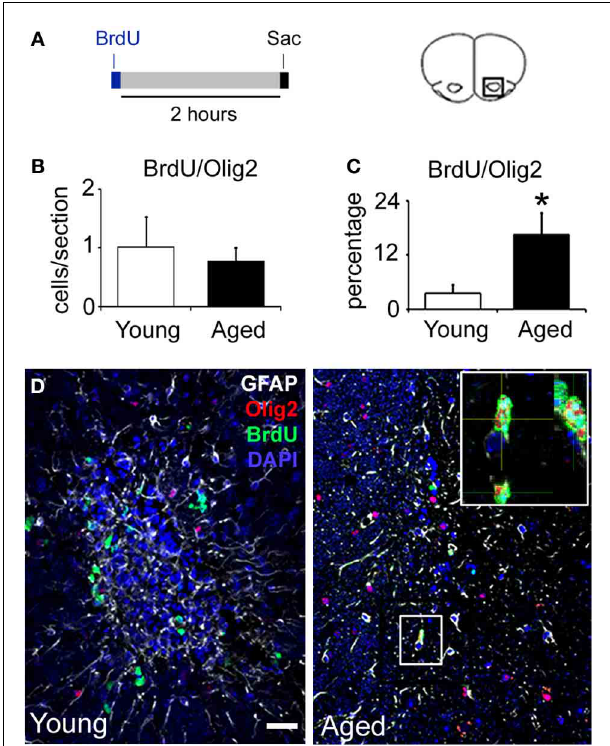
FIGURE 4 | A high percentage of the RMS proliferative cells pertain to the oligodendroglial lineage. (A) Animals received a single dose of BrdU and were euthanized 2h after. (B) Bar graph depicting the number of BrdU/Olig2 + cells in the RMS. Note that there is not a significant difference between young and aged mice. (C) Bar graph depicting the percentage of BrdU/Olig2 + cells in the RMS. (D) Immunostaining against BrdU (green), Olig2 (red), and GFAP (white) in coronal sections of the RMS. Note the presence of cells co-expressing BrdU and Olig2 markers. Sac, sacrifice. Scale bar: C = 20 µ m. ∗ p < 0 .